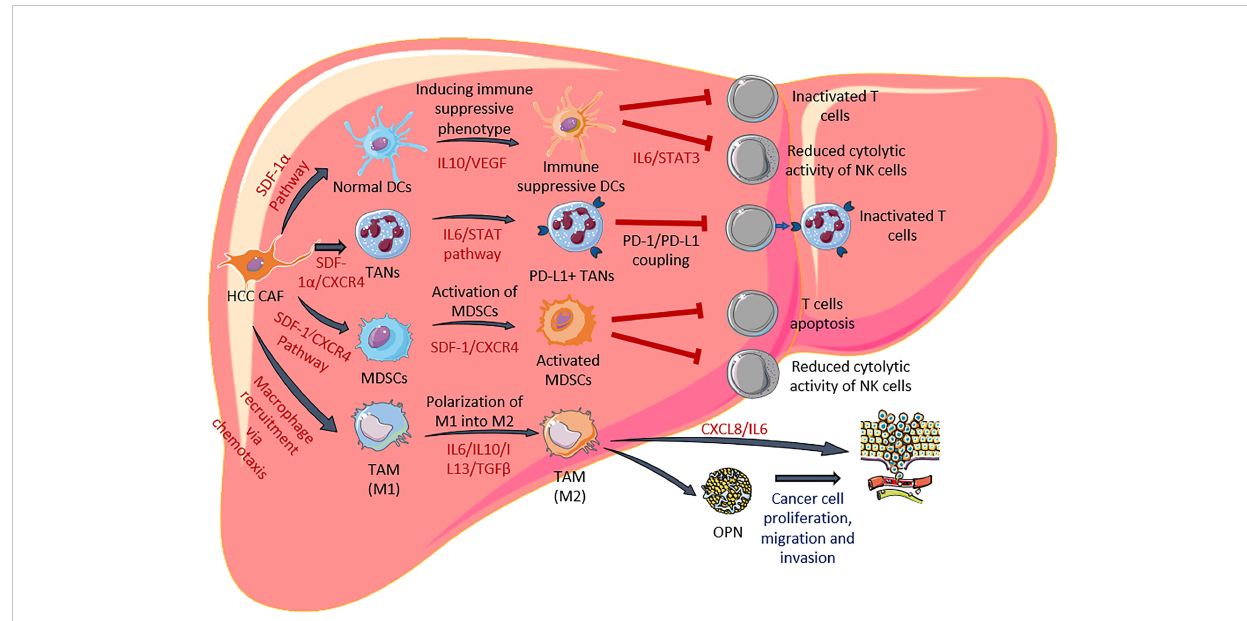
FIGURE 2 HCC CAF modulates functionalities of dendritic cells, neutrophils, MDSCs and macrophages. CAF secretes various factors to induce differentiation of immune suppressive DCs and PD-L1+ TANs. They are also involved in activation of MDSC and polarization of M2 macrophages. The cascade of these events leads to reduction of effector T cells and NK